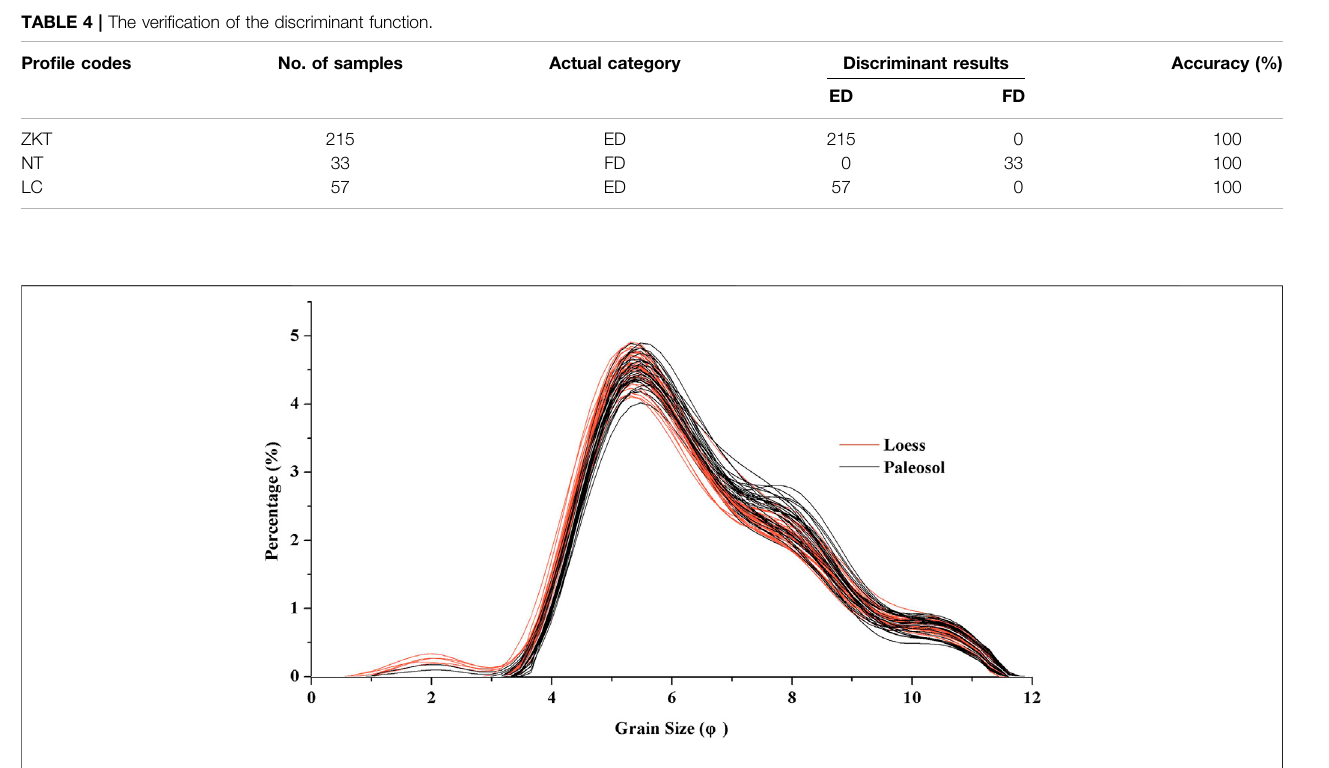
FIGURE 3 | The grain-size frequency curve of XG pro fi le.